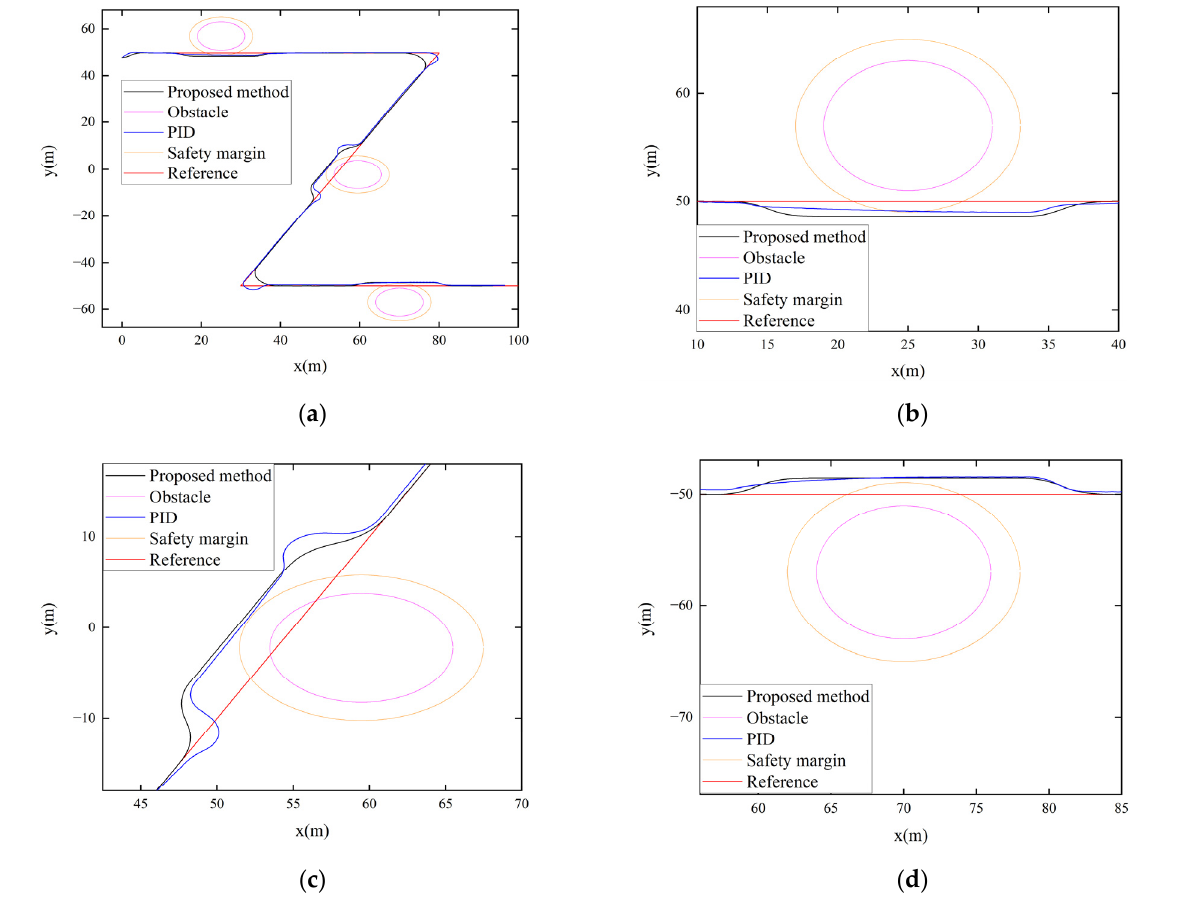
Figure 5. Simulation results of USV path 2 following with obstacle avoidance strategy: ( a ) path following results; ( b − d ) enlarged view of obstacle avoidance 1 to 3, respectively.